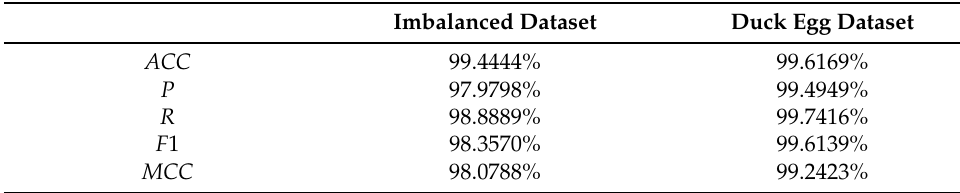
Figure 12. Crack detection results of eggs with different voltages by the method proposed in this paper. Where, 0 in the figure represents cracked eggs, and 1 in the figure represents intact eggs; The green line indicates that the tested sample is classified as intact eggs, and the orange line indicates that the tested sample is classified as cracked eggs. Table 5. Method performance and versatility